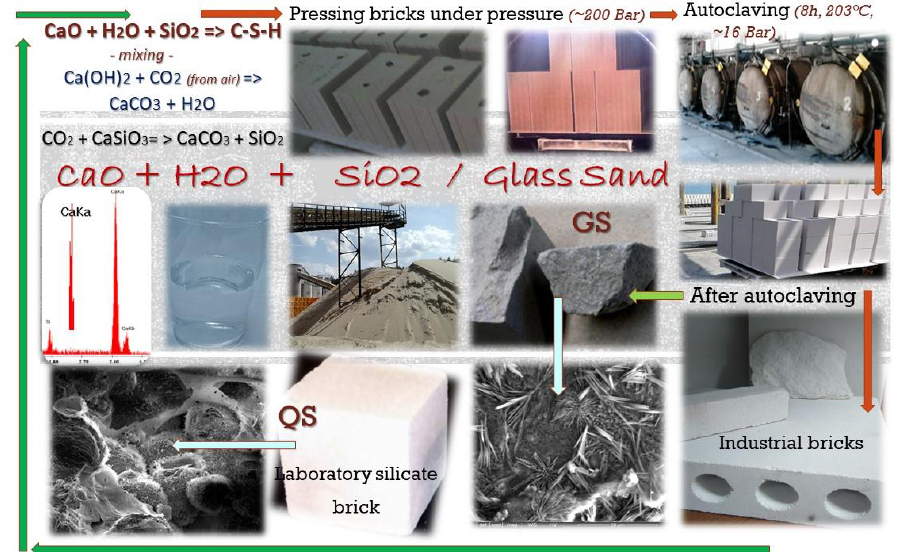
Figure 2. Production flow of traditional sand-lime bricks.